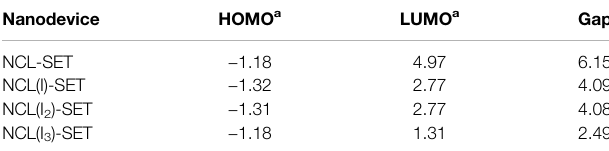
TABLE 3 | Nanocellulose single-electron transistor properties. a